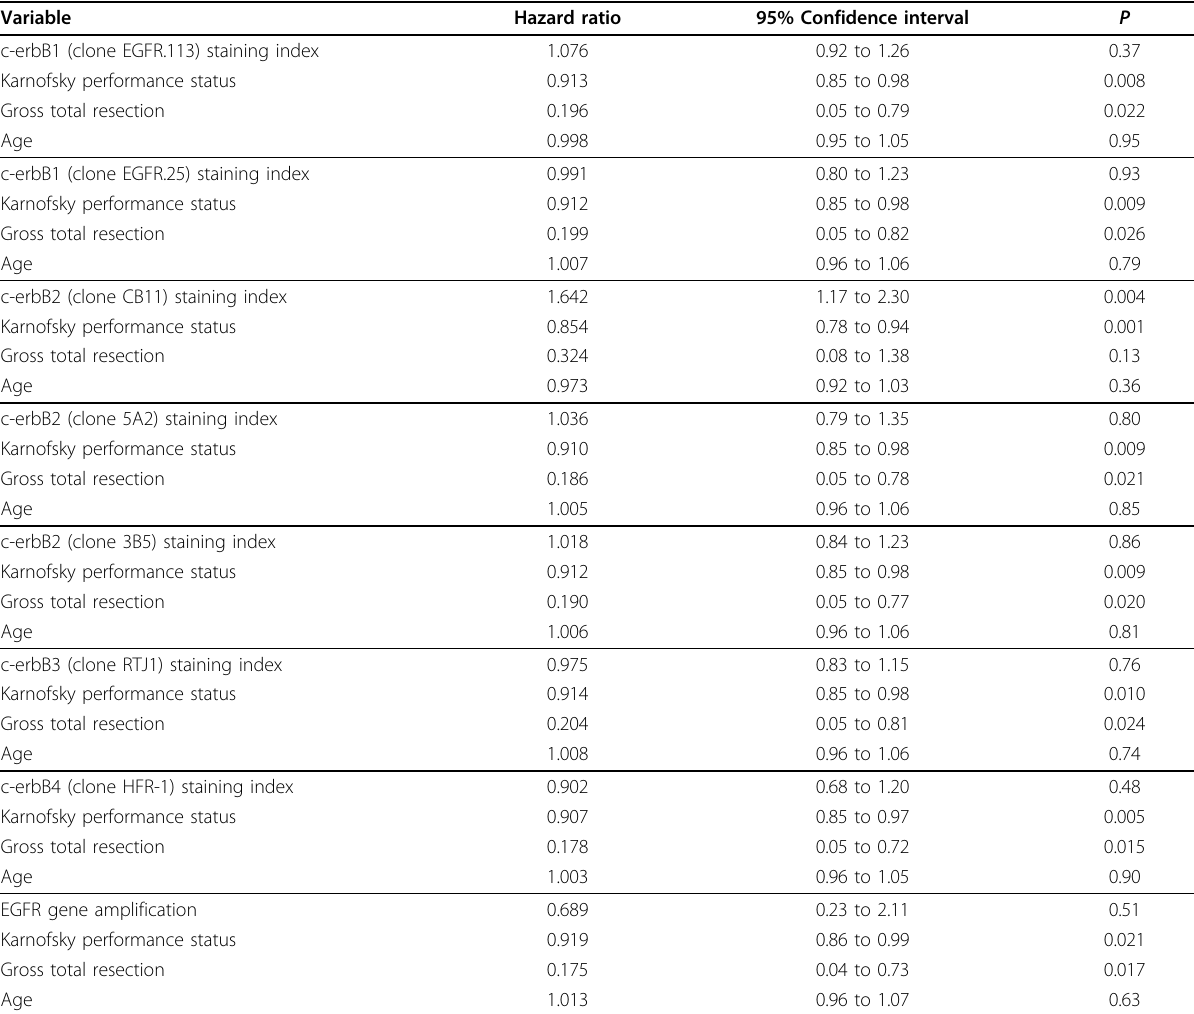
Table 4 Results from multiple Cox regression analyses Variable Hazard